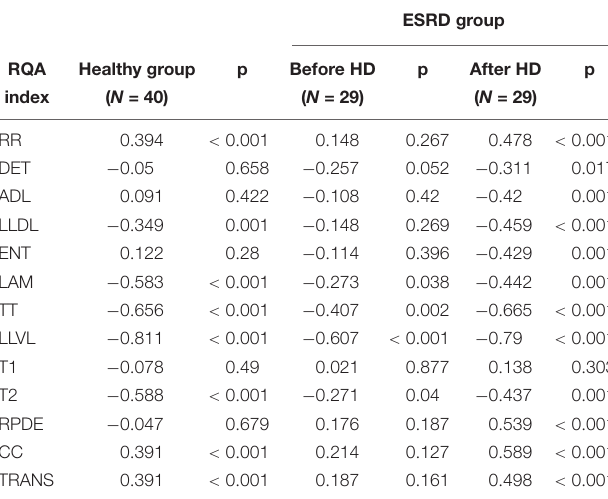
TABLE 6 | Spearman correlation coefficients between meanNN and recurrence quantitative analysis (RQA) indices for Pinned Wavelet Iterative Amplitude